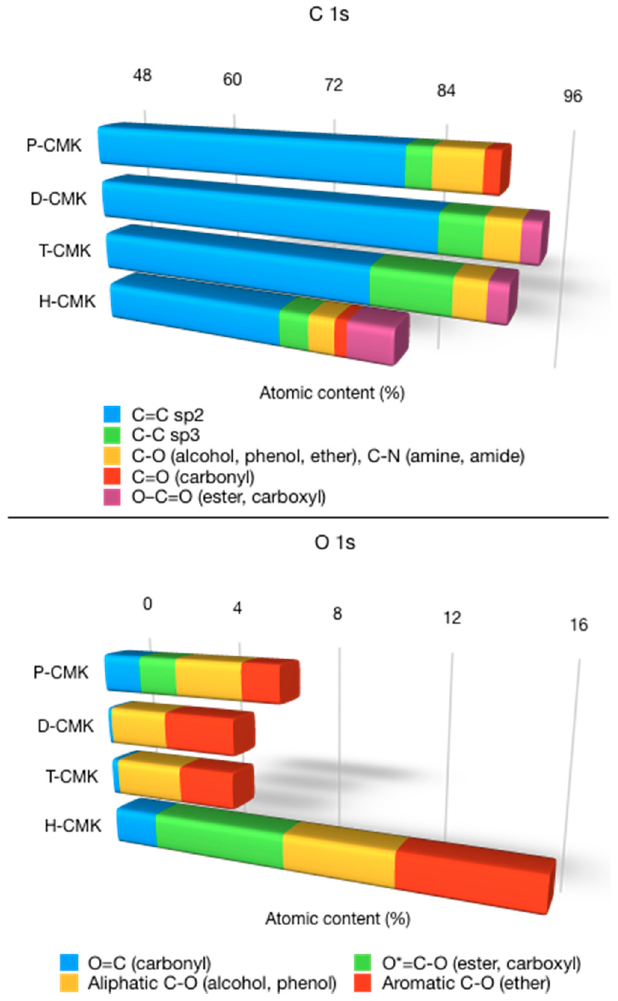
Figure 4. The results of the deconvolution of the XPS spectra of C 1s and O 1s core energy levels.